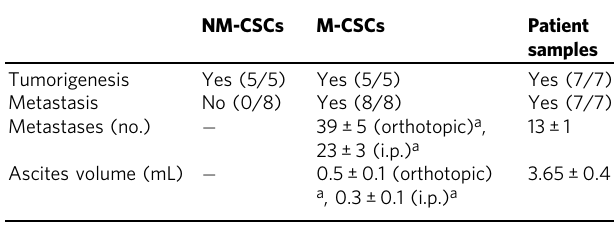
NATURE COMMUNICATIONS| (2019) 10:2406